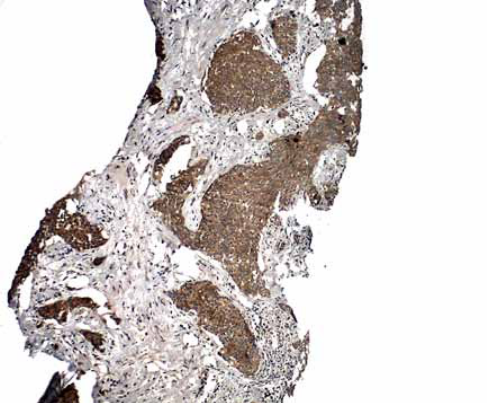
Figure 8 - PSA immunostain showing strong positivity in benign prostate glands, whereas the neuroendocrine tumor is faint to absent.